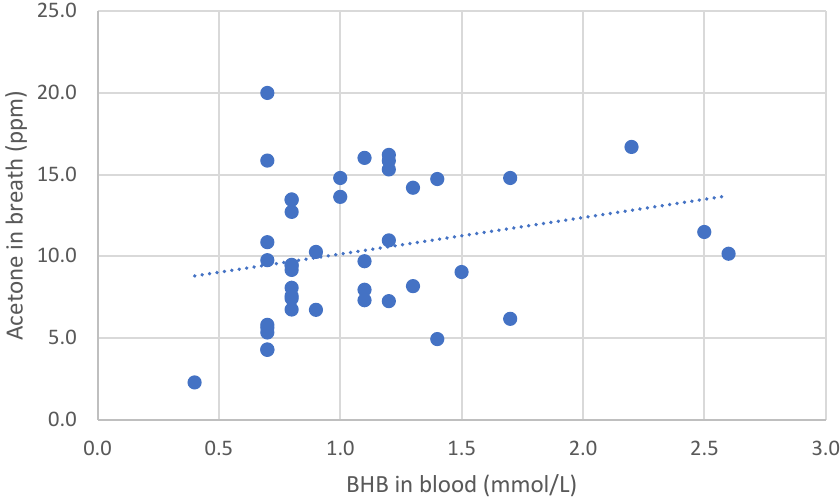
Figure 6. scatter plot of blood BHB and acetone in breath for all cows in the study ( n = 7). Model equation. 𝑦 = 2.65𝑥 + 7.02 .